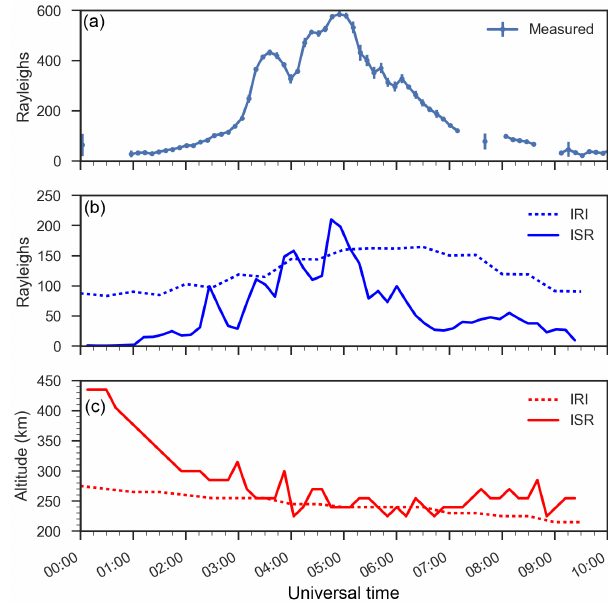
Figure 5. (a) 6300Å emission at zenith on 3 April 2014 as a func- tion of Universal Time. Brightness values are in rayleighs. Episodic decreases in brightness at 04:00UT and later are due to depletions passing through the field of view. (b) A model output from the BU airglow model showing brightness in rayleighs as a function of Uni- versal Time. The dotted line uses IRI-2012 for values of electron density and plasma temperature, and the solid line uses data mea- sured by the ISR at the Jicamarca Radio Observatory. The vertical axis is a different scale for the top and middle. (c) Altitude of peak emission as a function Universal Time also from the BU airglow model. The solid line uses data measured by the ISR at the Jica- marca Radio Observatory. The dotted line uses IRI for values of electron density and plasma